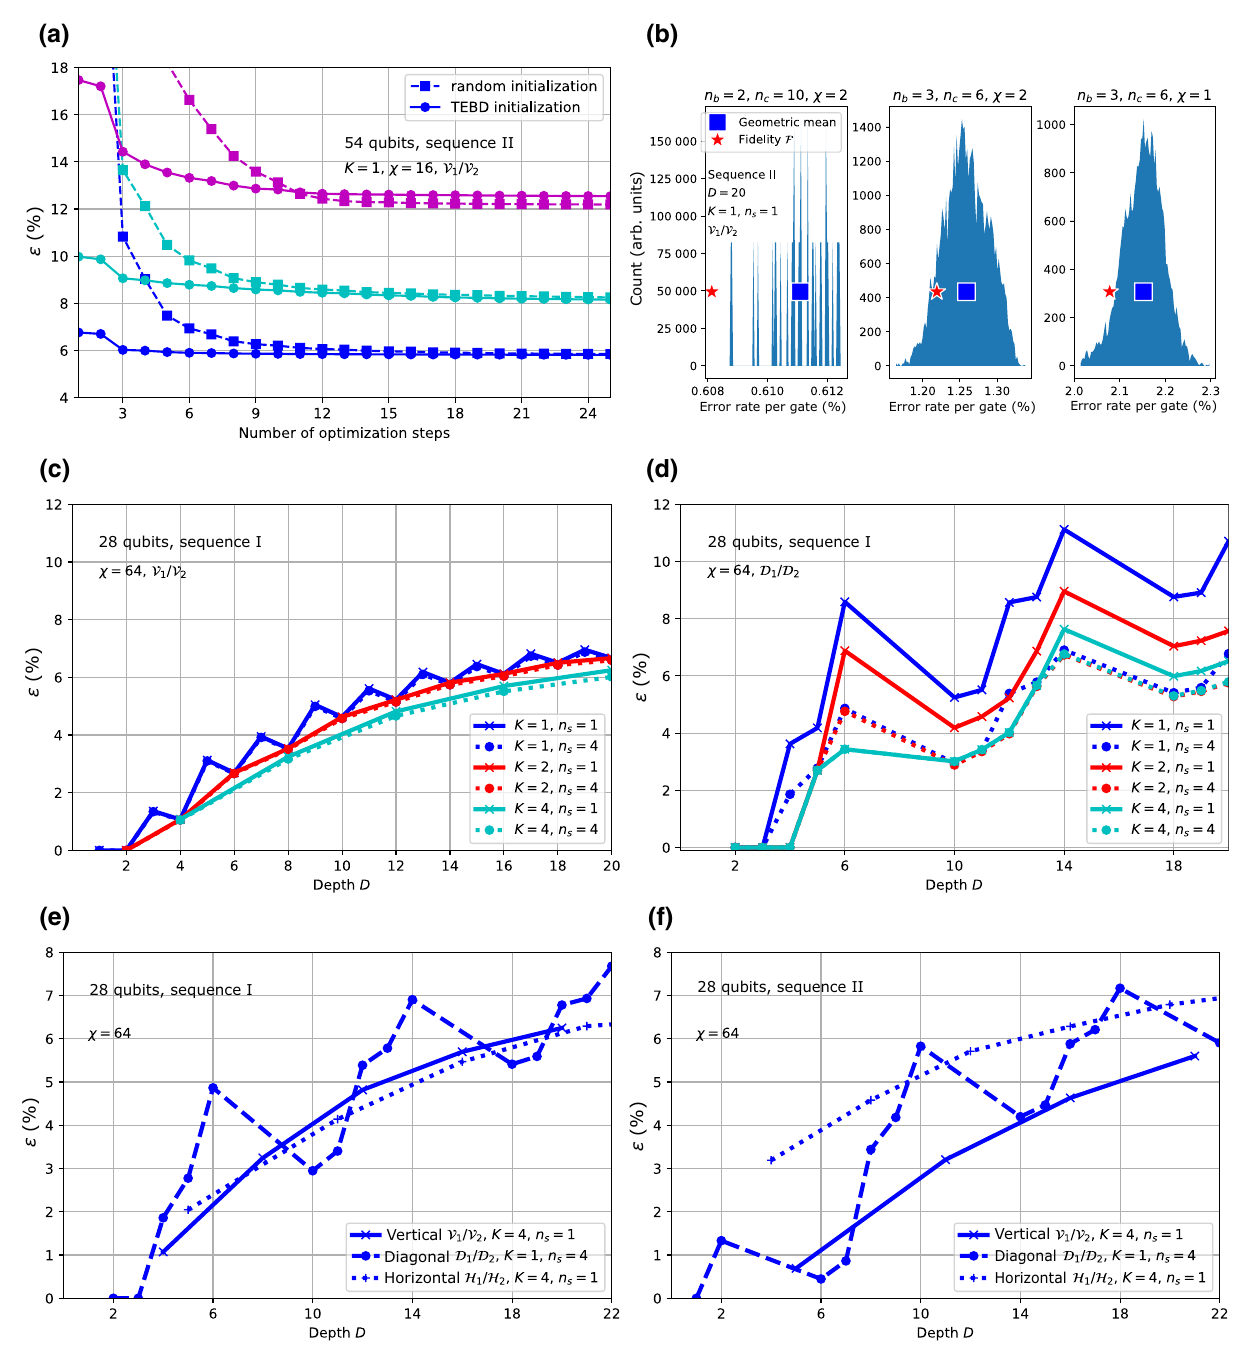
FIG. 8. Convergence of the DMRG algorithm. (a) Evolution of the error per gate versus the total number of local optimizations. Three steps correspond to a full sweep. Different colors correspond to different compression steps for a random (squares and dashed lines) and a TEBD (disks and solid lines) initialization. The different curves correspond to different compression steps in an open simulation [respectively the 4th (blue), 10th (cyan), and 12th (magenta) steps, with corresponding depths being D = 5, 13, and 16]. (b) Histogram of the error rates per gate (cid:5) x of the amplitudes of individual bitstrings x computed using closed simulation for various (cid:3) (cid:5) ) 1 / 2 N . Red stars denote the exact error per gate 1 − F 2 /( ND ) . (c),(d) Role n b , n c , and χ . Blue squares denote the geometric mean ( x x of K and the number of sweeps n s . Evolution of the error rate per gate (cid:5) versus depth D for various numbers of layers K and numbers of sweeps. Parameters are χ = 64, n b = 4, and n c = 8. (c) Vertical ordering: groupings V 1 , V 2 . (d) Diagonal ordering: groupings D 1 , D 2 . (e),(f) Role of the choice of qubit groupings and of the sequence of gates applied. Evolution of the error rate per gate as a function of current depth. (e) Sequence I, used in the Google supremacy experiment. (f) Sequence II, a variation on the supremacy